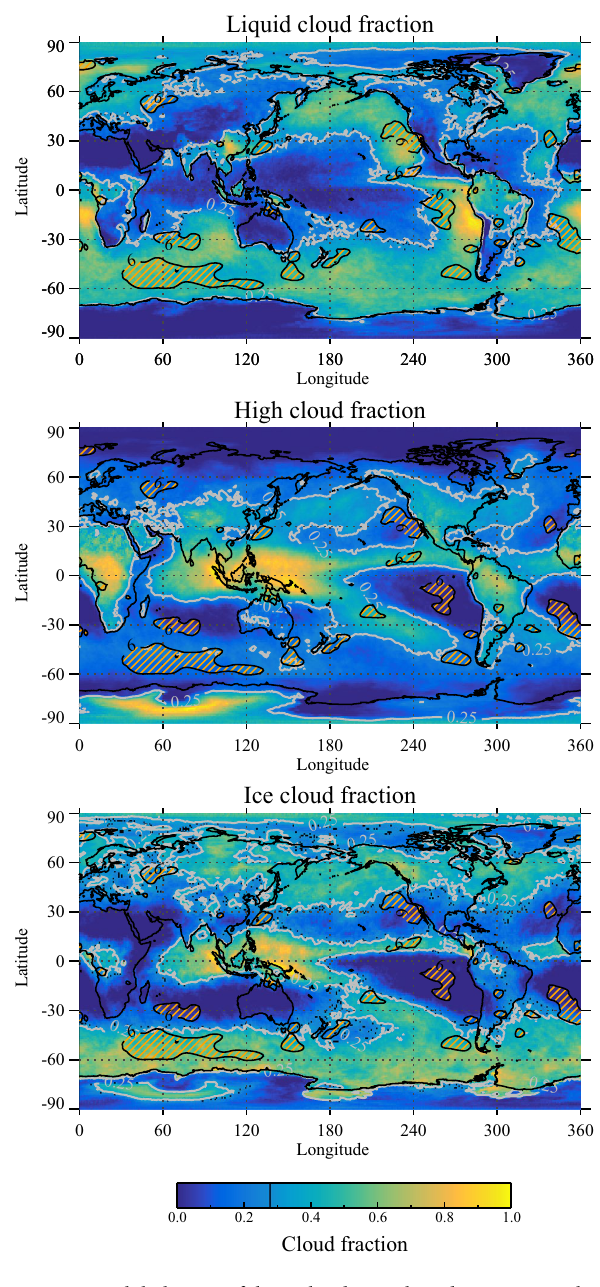
Figure 6. Global maps of three cloud types based on MODIS observations. The top panel is regions with liquid clouds (mainly the green regions). The middle panel is high clouds. The bottom panel is the ice-cloud-fraction. The gray contour lines on all three maps show threshold cloud fraction 0.25 used for the cloud masks. The fractional area of Earth with cloud types exceeding the threshold are: a (Liquid clouds) = 0.52, a (High clouds) = 0.44 and, a (Ice clouds) = 0.40. Superposed on all three maps are the (orange hatched) regions with large responses found in CERES TOA net radiation following the minimum in cosmic rays (black contour lines are 6 2 W/m ). Note that these regions are almost exclusively confined to areas dominated by liquid